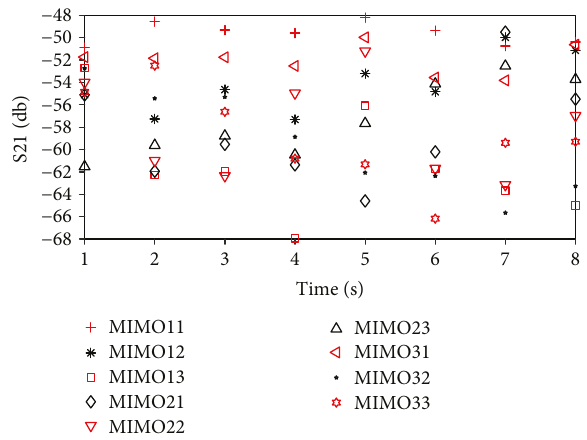
Figure 13: S21 values of moving cuboid candles within 8s by means of MIMO